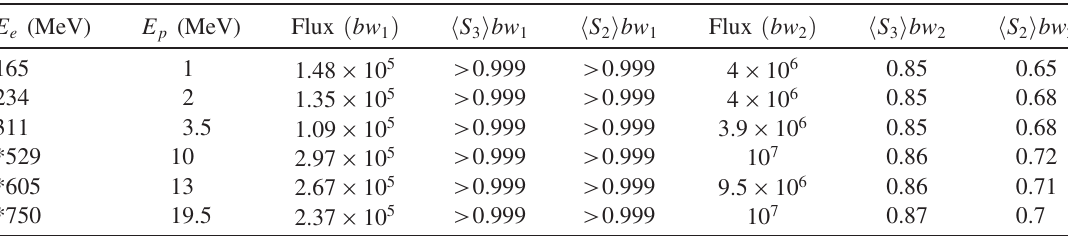
TABLE II. Average values of flux and of the Stokes parameters h S 3 i and h S 2 i for both linear and circular laser polarization and various working points, in the bandwidth bw 1 ¼ 5 × 10 − 3 and for a larger acceptance, corresponding to a bandwidth of bw 2 ¼ 0 . 2 . Laser energy at 0.2 J. In the cases with star, the laser energy is 0.4 J.